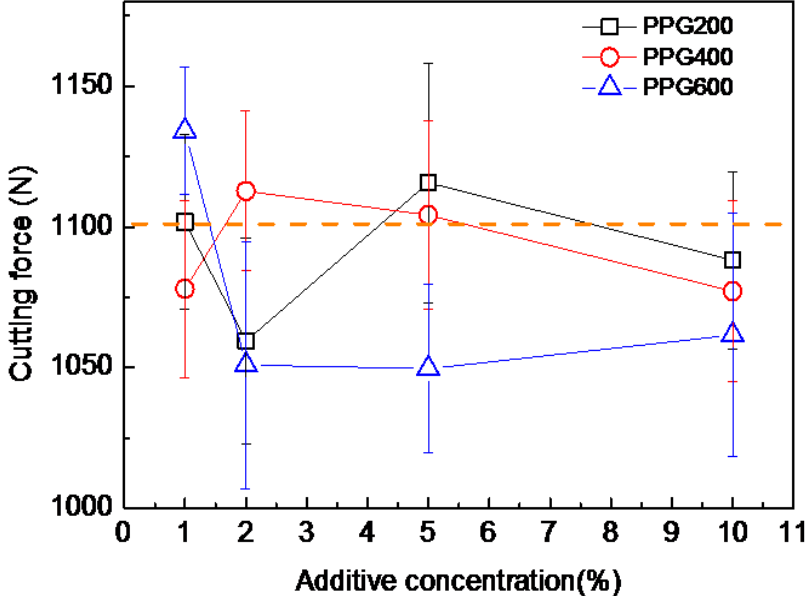
Figure 9. Impact of polypropylene glycol (PPG) additive on cutting force at 1 mm cutting depth and 65° back rake angle. Dashed line is the cutting force without additive.